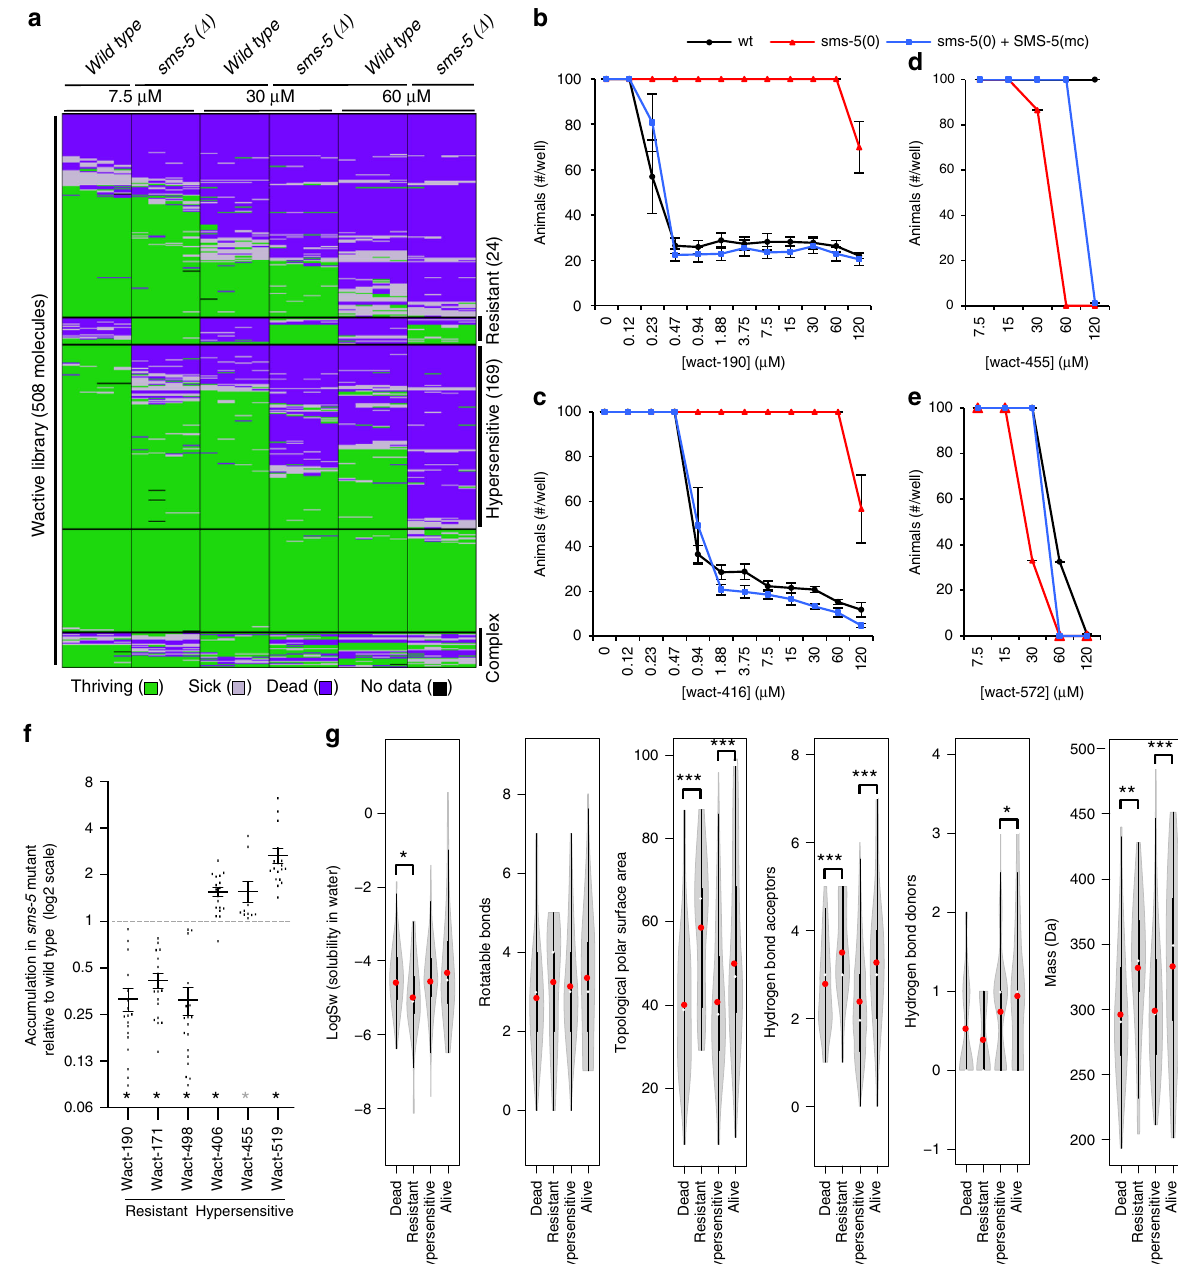
Fig. 7 sms-5 mutants have altered sensitivity to small molecules. a L1 viability assays of animals of the indicated genotype (top) grown in liquid culture in quadruplicate in 508 different wactive small molecules at 7.5, 30, or 60 μ M. Wells were inspected after 6 days of growth; wells that had ≥ 50 animals are shown in green, wells that have between 11 and 50 animals are shown in yellow, and wells with ≤ 11 animals are shown in red. The resulting population growth of each of the four replicates is shown in each column. Each row corresponds to a distinct wactive molecule. The data are clustered along the y axis. The 24 wactives with reduced potency in the mutants are referred to as resistant wactives, and the 169 wactives with increased potency in the mutants are referred to as hypersensitive wactives. b – e Dose – response analyses of C. elegans population growth with two resistant molecules (wact-190 and wact-416) and two hypersensitive molecules (wact-455 and wact-572). The sms-5(ok2498) deletion mutant ( “ sms-5(0) ” ) was used in this analysis, along with the rescuing sms-5 transgene whereby SMS-5::FLAG::mCherry (SMS-5(MC)) is expressed exclusively in the anterior marginal cells. Resulting wells with <50 animals in the wact-190 and wact-416 conditions were invariably arrested or dead L1s. Viability counts were done with n = 8 independent experiments; crystal counts were done with n = 3 independent experiments. f Accumulation of the indicated small molecule in the sms-5(ok2498) mutant relative to wild-type L1 animals as measured by mass spectrometry. Standard error of the mean is shown for graphs b – f . n = 6 independent experiments for wact-190, wact-171, wact-498, wact-406, and wact-519; n = 4 for wact-455. g Violin plots comparing the physical – chemical properties of molecules that are classi fi ed as lethal in all conditions (dead), resistant, hypersensitive, or not obviously bioactive (alive) at 30 μ M. See the legend of Fig. 1 for the description of the violin plots. One, two, and three asterisks indicate a signi fi cant difference ( p < 0.05, p < 0.01, and p < 0.001, respectively) between the indicated datasets using Student ’ s T test. Source data are provided in the Source Data fi le